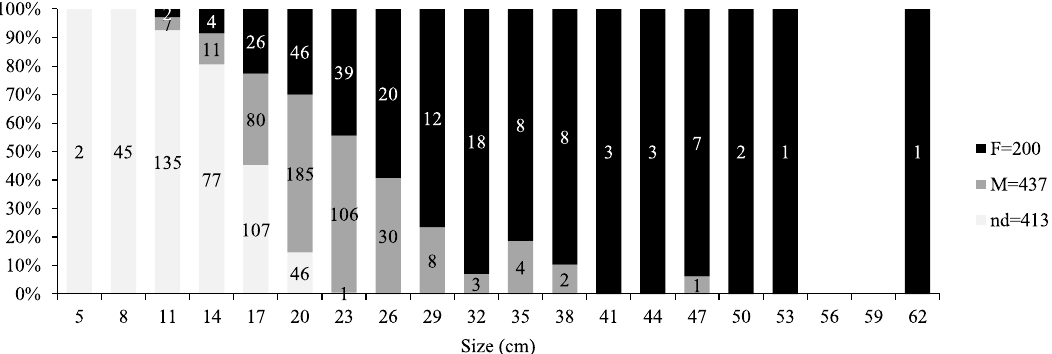
Fig. 7. Length frequency distribution of P. blennoides by sexes from landing of commercial fi sheries (F: female, M: male, nd: undetermined, X axis: Lower limit of size class).